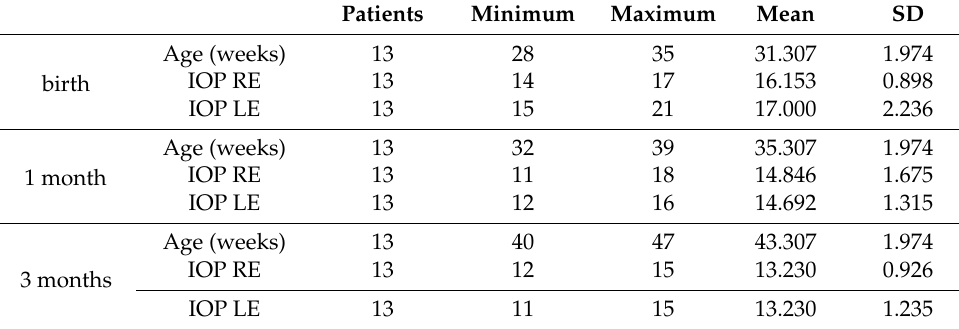
IOP—intraocular pressure, RE—right eye, LE—left eye.